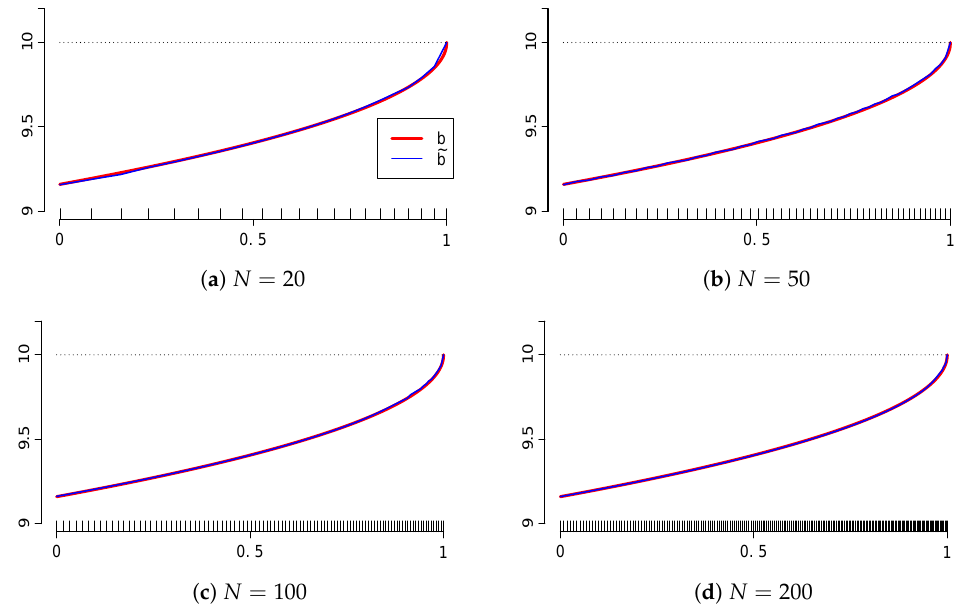
Figure 1. Boundary estimation via Algorithm 1 for different partition sizes and for the parameters S = 10, T = 1, λ = 0, and σ = 1. The estimation becomes more accurate as the partition gets